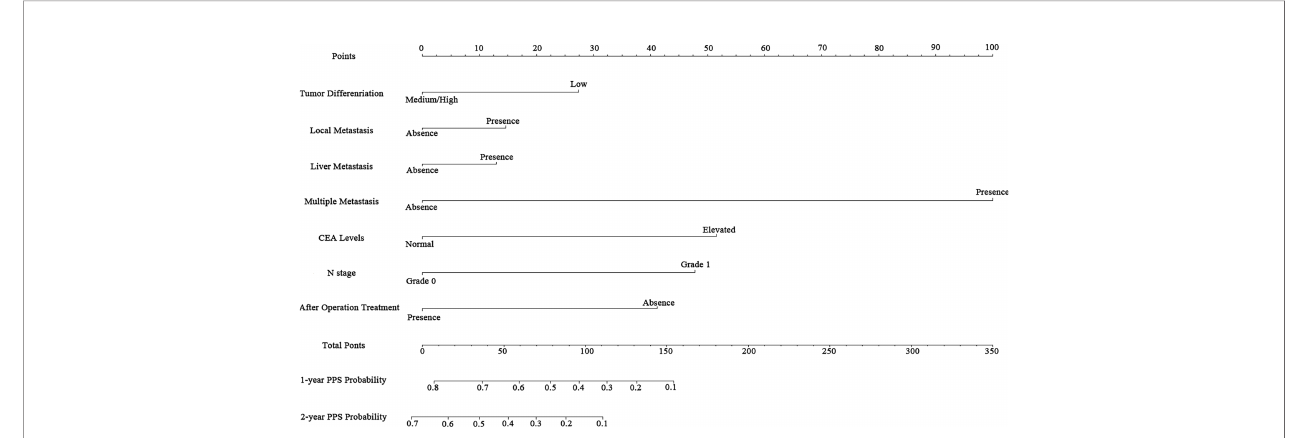
FIGURE 3 | Nomogram for predicting the 1- and 2-year post-progression survival rates in patients with